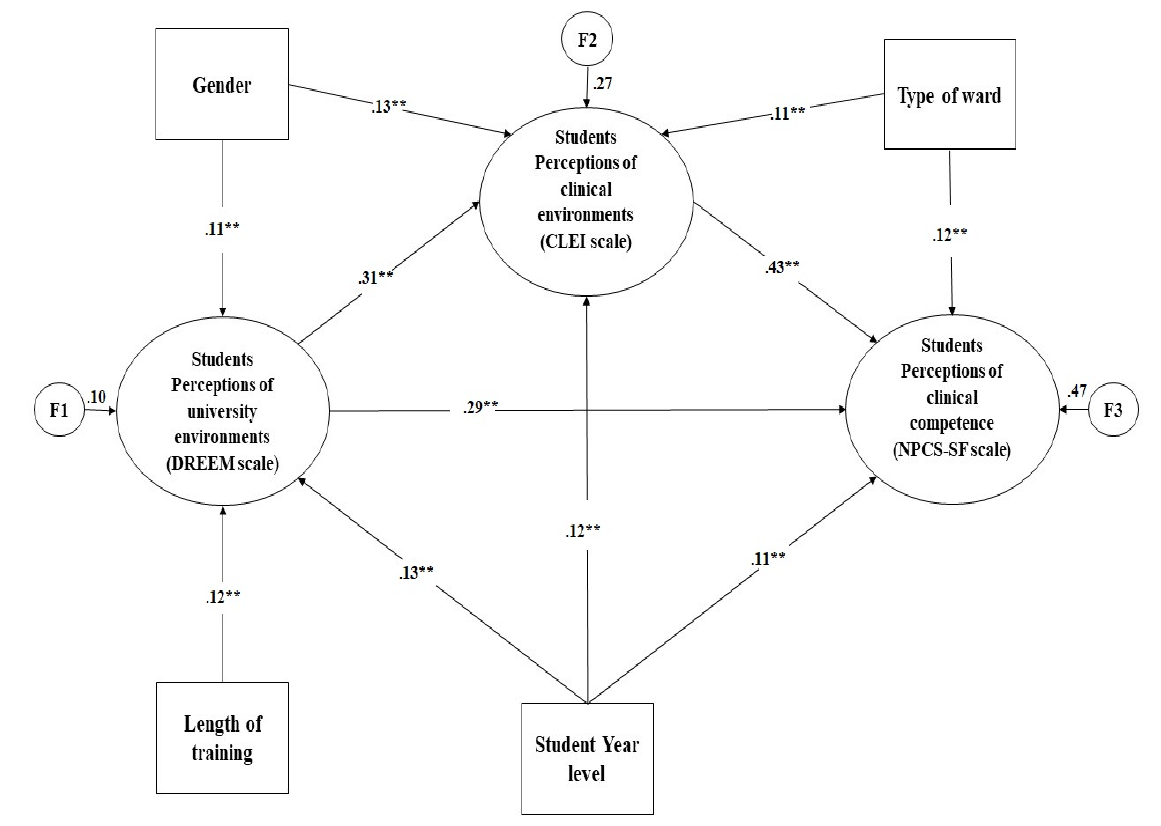
Figure 3. The modified final model predicting nursing students’ perceptions of professional competence, university environment, and clinical environment. * p < 0.05, ** p < 0.001.